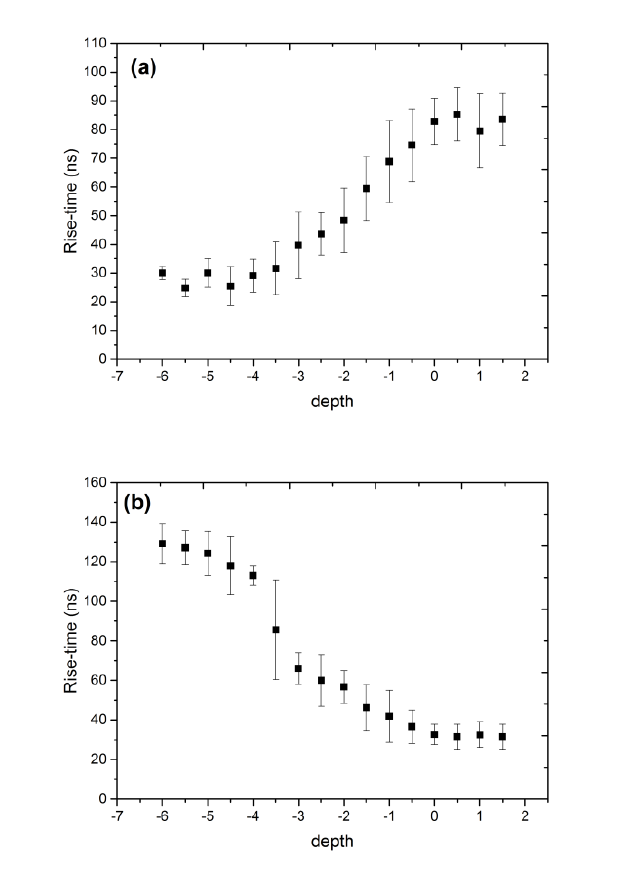
Fig. 6: T30 rise-time values as a function of depth for (a) DC4 and (b) AC20 segments, respectively. In this figure, X-axis represents depth, i.e., going from the front to the backside of the detector. The values plotted are the centroids of the rise-time distribution obtained for each depth. The error has been calculated for each data point from the rise- time distribution spread, as indicated in Fig. 5. For DC4 (Fig. 6(a)), with an increase in depth, rise-time increases. Fig.